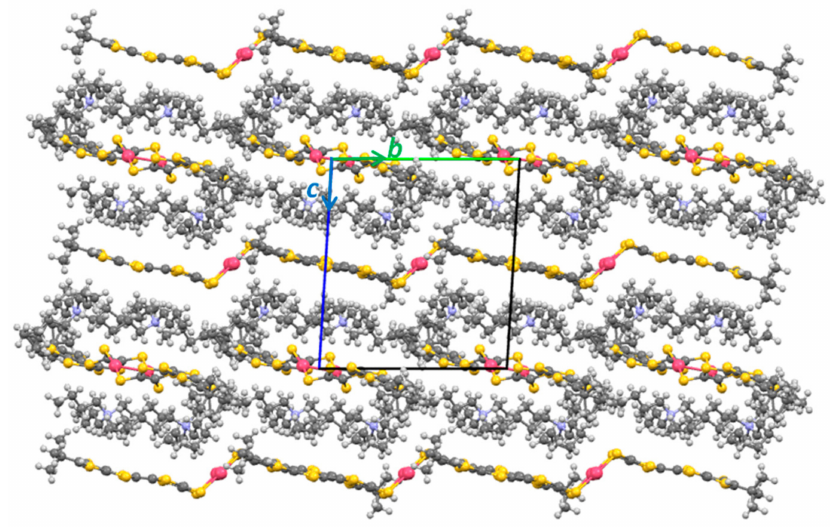
Figure 5. ( n -Bu 4 N) 2 [Au 2 ( α -tbtdt) 2 ] ( 5 ) crystal structure viewed along the a -axis.